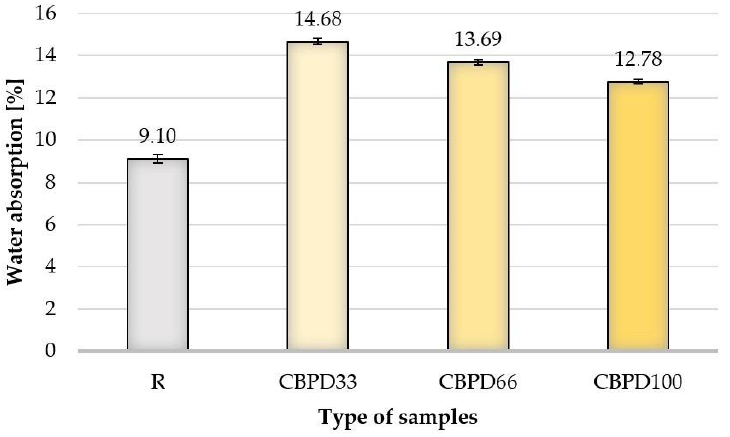
Figure 6. Water absorption results.